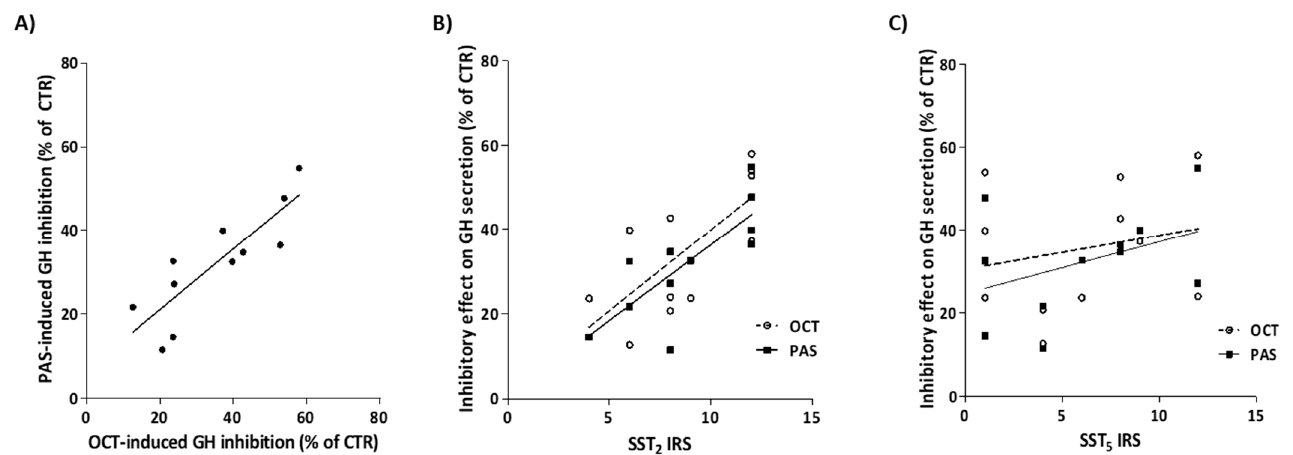
Figure 3. Correlation between the inhibitory OCT and PAS effects on GH secretion and SST 2/5 protein expression in somatotroph tumors. ( A ) Correlation between OCT- and PAS-induced inhibition of GH secretion in eleven somatotroph tumor cell cultures. Each dot represents a single patient. ( B , C ) Correlation between SST 2 (panel B) or SST 5 (panel ( C )) IRS and the inhibitory effect on GH secretion of OCT and PAS in 11 adenoma cell cultures. (CTR, control; OCT, octreotide; PAS, pasireotide; IRS, immunoreactivity score).